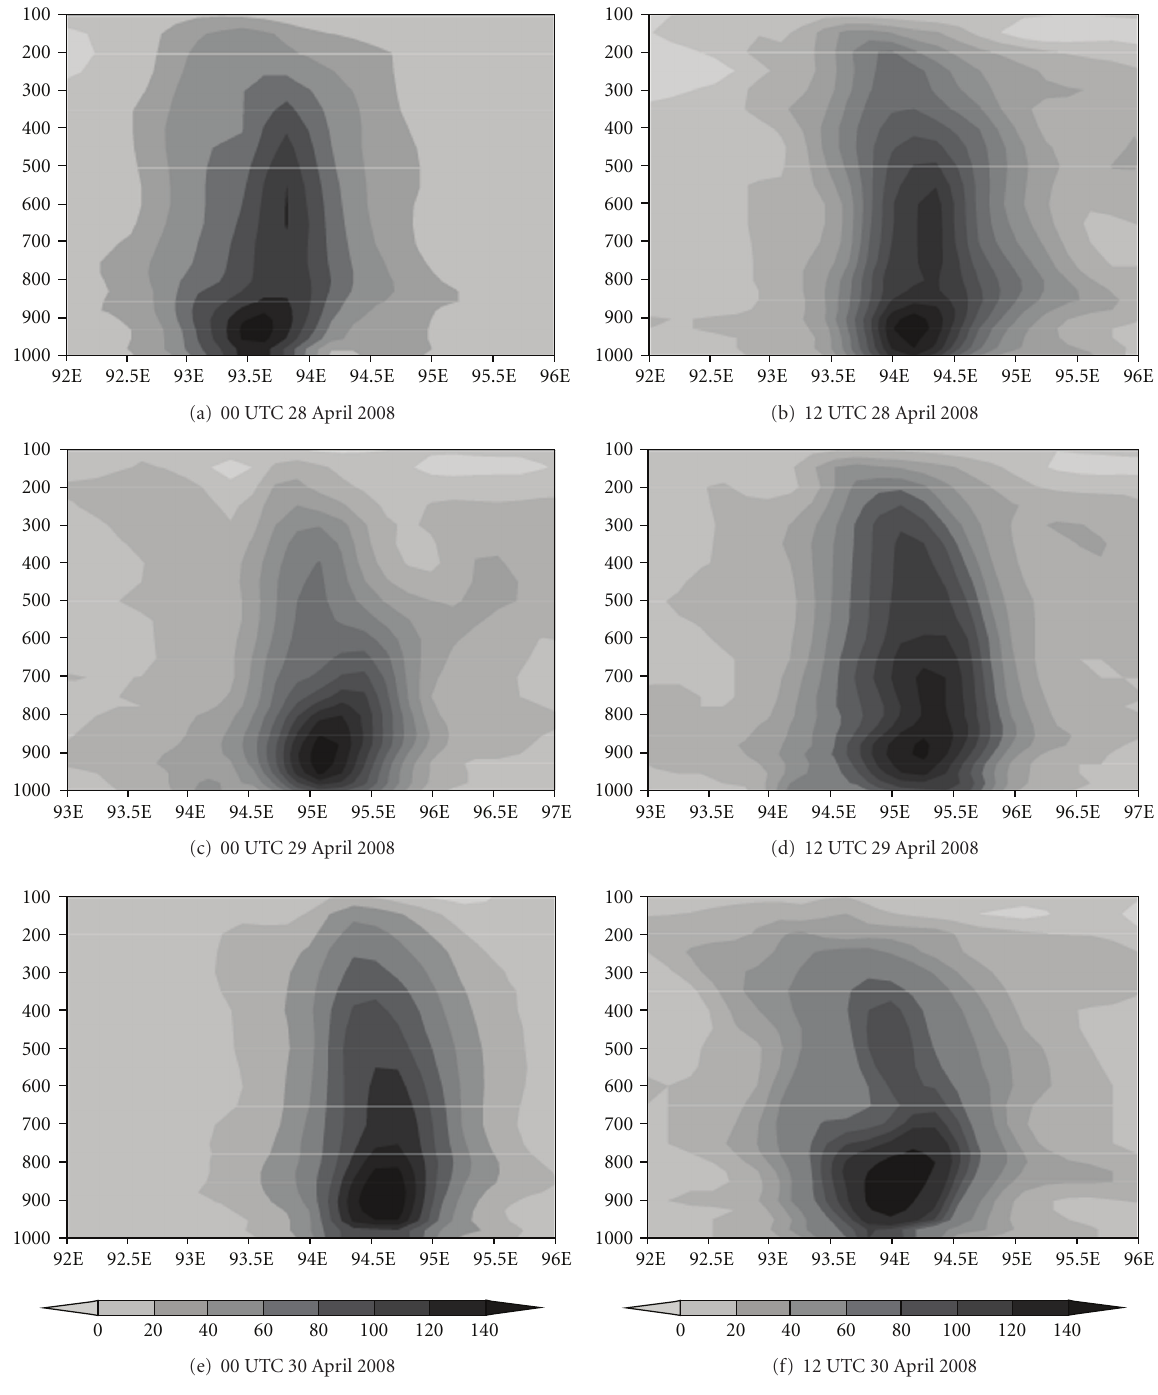
Figure 12: Model-simulated absolute vorticity ( × 10 − 5 s − 1 ) at the peak intense time with di ff erent initial conditions with NMM land surface